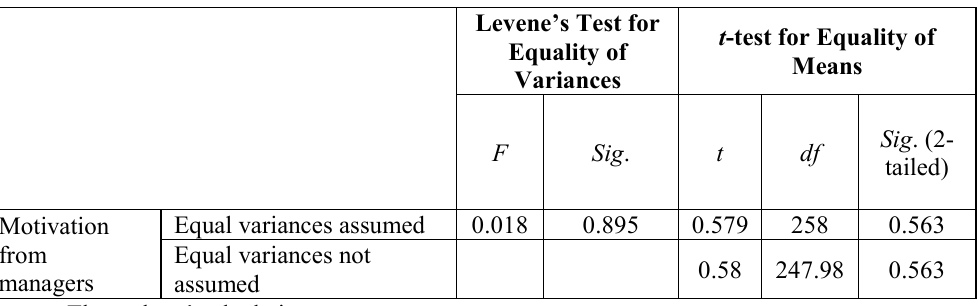
Table 4. Test of Motivation as an Independent Variable